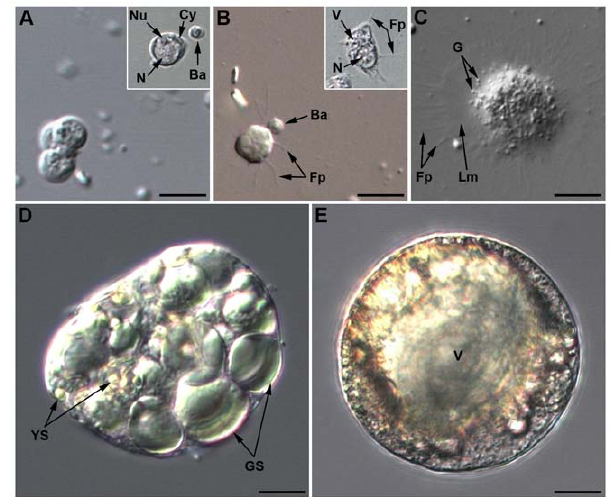
Figure 1. Light microscopy pictures of Acyrthosiphon pisum hemocytes (LL01 clone). (A) Three prohemocytes in cluster. Inset: phase contrast showing the large central nucleus and the nucleolus ( Nu ). Ba: B. aphidicola . (B) Plasmatocyte beginning to adhere, with filopodia ( Fp ) extension. Inset: phase contrast showing large cytoplas- mic vacuolar formation. (C) Adherent granulocyte containing cytoplas- mic granules ( G ) and filopodia ( Fp ) extending from a lamellipodium ( Lm ). (D) Spherulocyte with its large colored globular inclusions, small yellow spherules (YS) and large green spherules (GS) . (E) Wax cell showing a large central vacuole (V) and colored globular inclusions that differ from those of spherulocytes. Same magnification for all micrographs; scale bar: 10 m